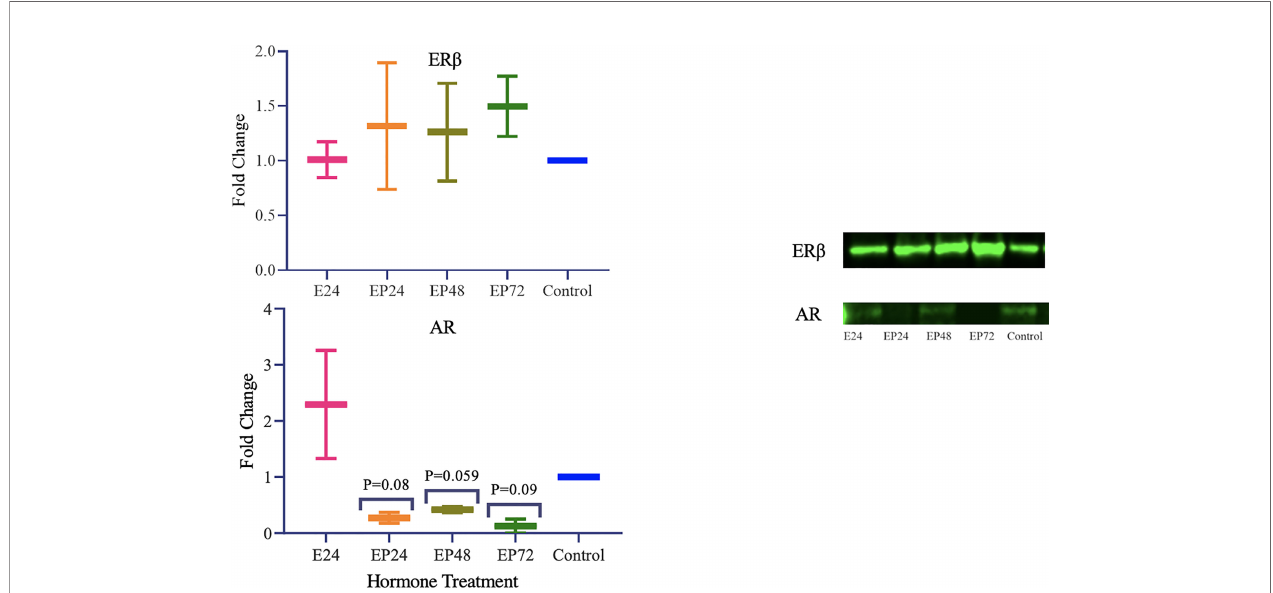
FIGURE 3 | Steroid hormone protein expression in response to different steroid hormone treatments in AN3 cells. A representative blot image for the particular weight band is shown next to the graph. The y-axis shows the fold change of protein levels following different treatments compared to control and x-axis shows the different treatment groups. E24 = 24h Estrogen; EP24, EP48 and EP72 = both Estrogen + Progesterone for 24, 48 and 72h. Data are presented as mean ± SEM. P ≤ 0.1 is considered as approaching signi fi cance. The experimental setup included three independent sets of cell culture experiments (n =3) with three technical replicates for each sample.